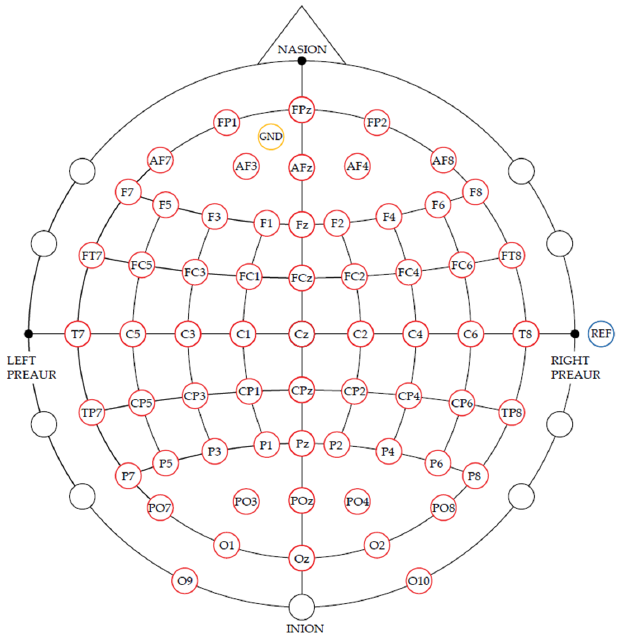
Figure 1. 64 EEG electrodes placed on the scalp according to the 10-10 international system.